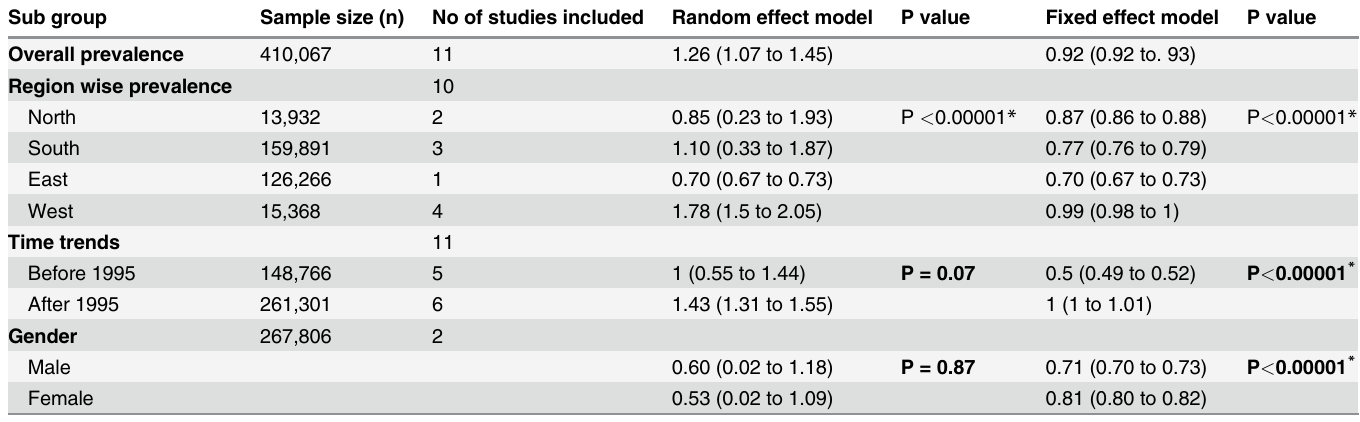
Table 4. Summary table of the data from studies included on orofacial clefts; the table depicts comparative data using fi xed and random effects